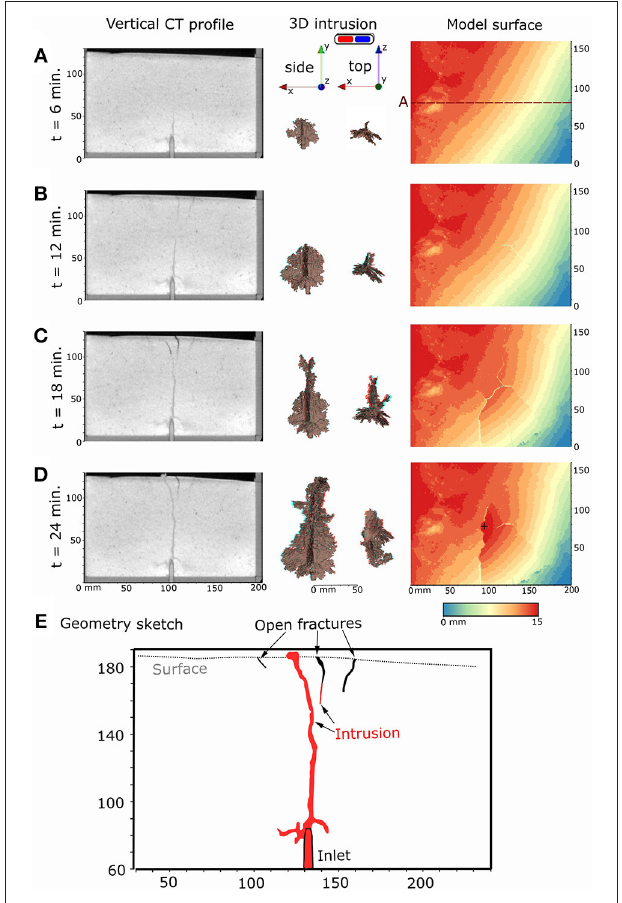
FIGURE 7 | (A–D) Temporal evolution of a dike intrusion in a 50:50 wt% sand:plaster mixture (SPCTIN04 in Table 2 ): (Left column) vertical x-y slice of reconstructed CT volumes through the model center; (Central column) 3D anaglyphs of the intrusion seen from its side (left) and its top (right) rendered from CT images, to be viewed with blue-red 3D glasses; (Right column) Model surface elevation extracted from resampled CT images, the black cross marks where syrup broke through the surface (i.e., eruption); (E) Structural sketch of the final intrusion and induced deformation structures in the overburden through the central x-y slice in (D) ( t =